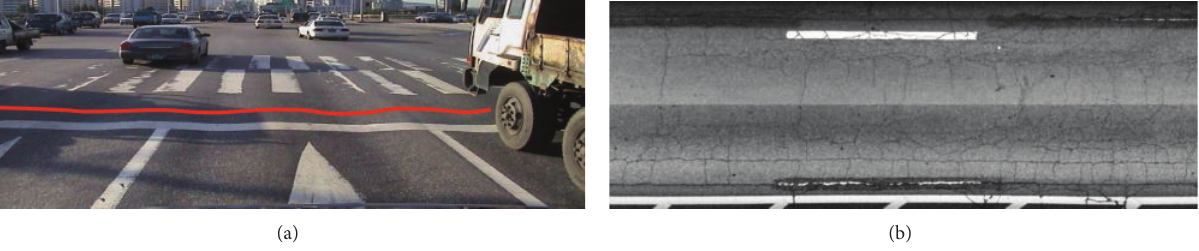
Figure 1: Pavement distress: (a) rutting and (b) fatigue cracking.